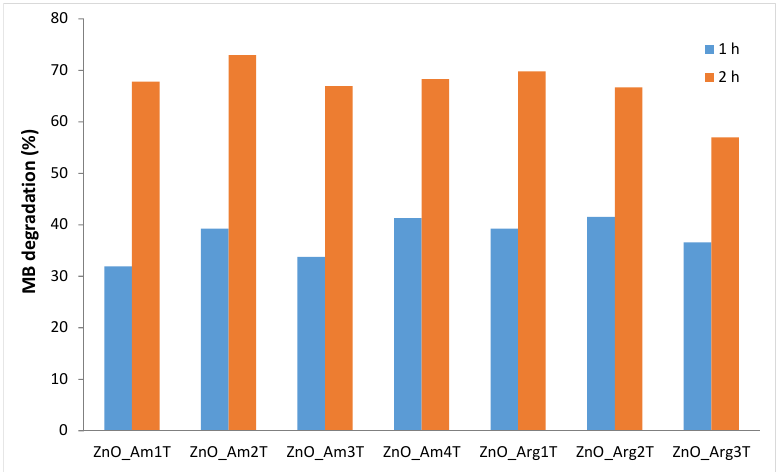
Figure 9. Efficiency of MB removal of ZnO-modified cotton samples. Reaction conditions are detailed in Table 1.